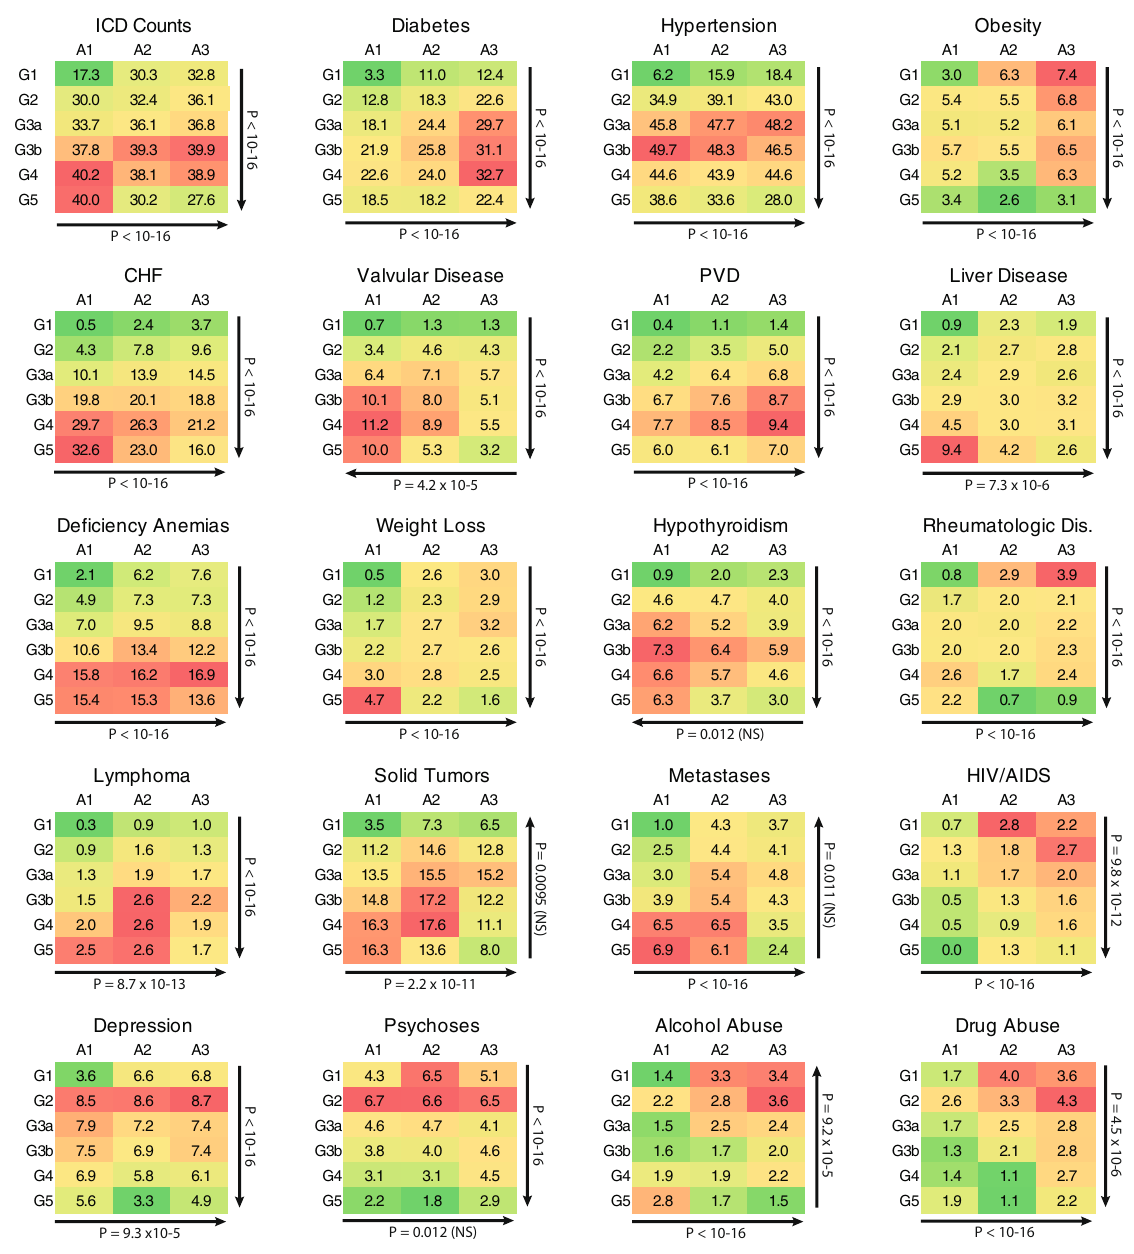
Fig. 2 Comorbidity heatmaps for 239,332 CUIMC patients algorithmically placed on the A-by-G grid. The prevalence of a comorbidity within each cell is provided, with the shaded color scale varying from red (highest prevalence) to green (lowest prevalence). The arrows correspond to the direction of effect and P values the statistical tests of comorbidity gradients across the grid. The analysis excludes individuals with missing urine tests and those with ESRD on dialysis or after transplant. Models based on logistic regression was used for binary traits and Poisson regression for ICD counts. All models were adjusted for age and sex and P value <6.25 × 10 − 4 is considered as signi fi cant after Bonferroni correction. NS not signi fi